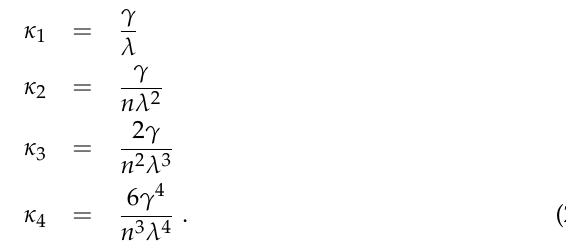
cumulants from Equation (20) together with their respective root from Equation (13) or (19)